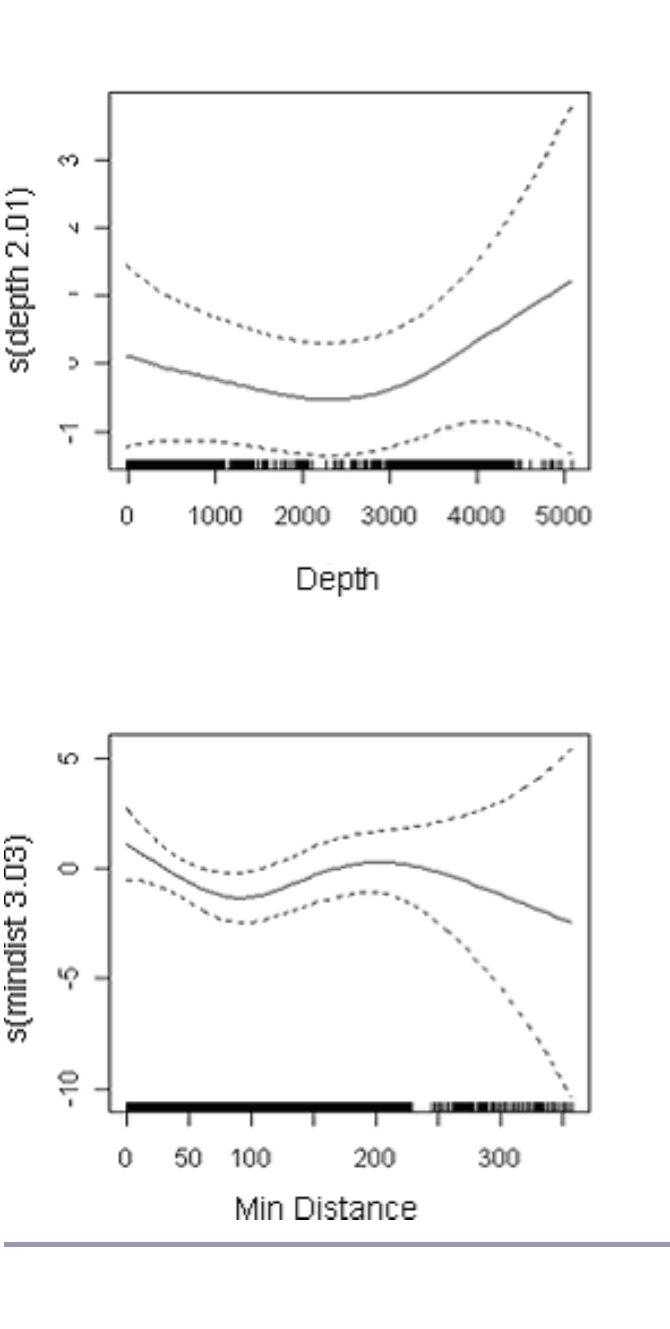
APPENDIX 4. Smoothed components (solid line) of three explanatory variables (x-axes) used in the